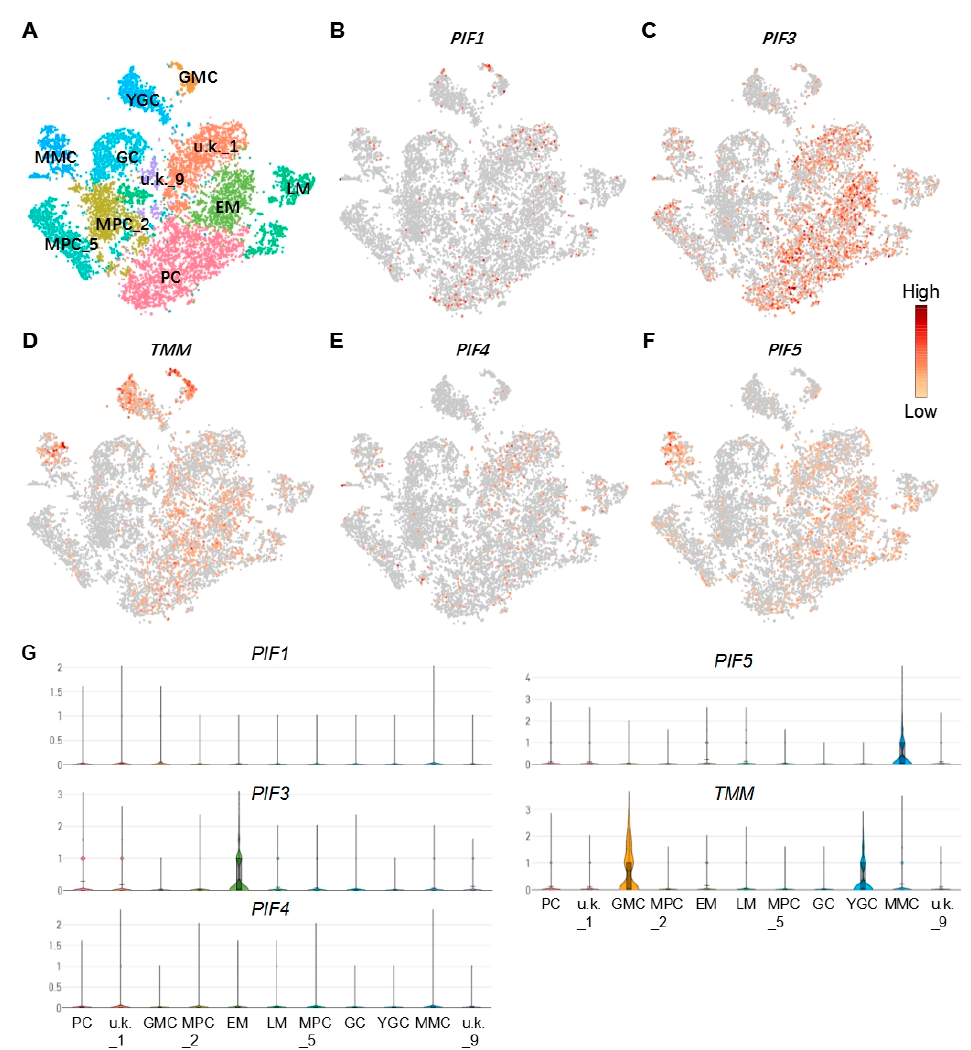
Figure 1. Analysis of the feature of PIF and TMM genes in epidermal cells. ( A ) A model demonstrates the distribution of cell types on tSNE plot; corresponding cell types are annotated on the plot. ( B – F ) Feature plots show the expression patterns of TMM , PIF1 , PIF3 , PIF4 , and PIF5 , respectively. ( G ) Violin plots show expression levels of TMM , PIF1 , PIF3 , PIF4 , and PIF5 , in each cell type. PC: pavement cell; M: meristemoid; GMC: guard mother cell; GC: guard cell; MMC: meristemoid mother cell; EM: early stage meristemoid; LM: late stage meristemoid; YGC: young guard cell; MPC: mesophyll cell; u.k.: